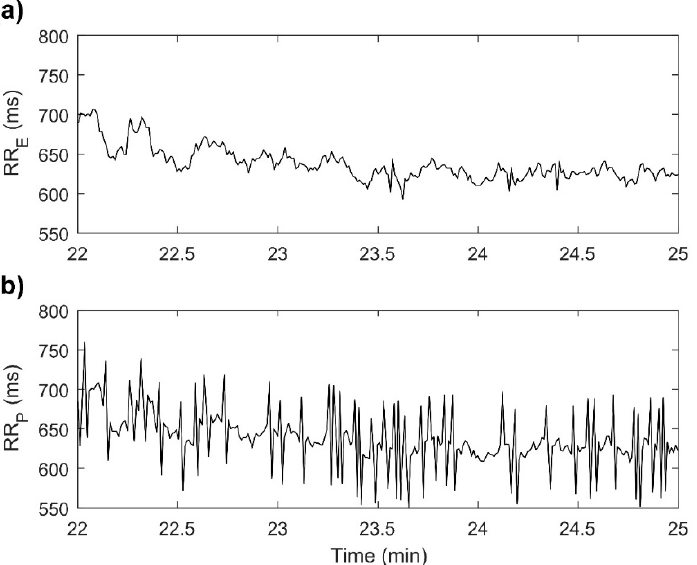
Figure 3. Example of RR intervals recorded by both devices during the recovery segment for one subject. ( a ) RR E = RR intervals series recorded by ECG; ( b ) RR P = RR intervals series recorded by PolarH7.